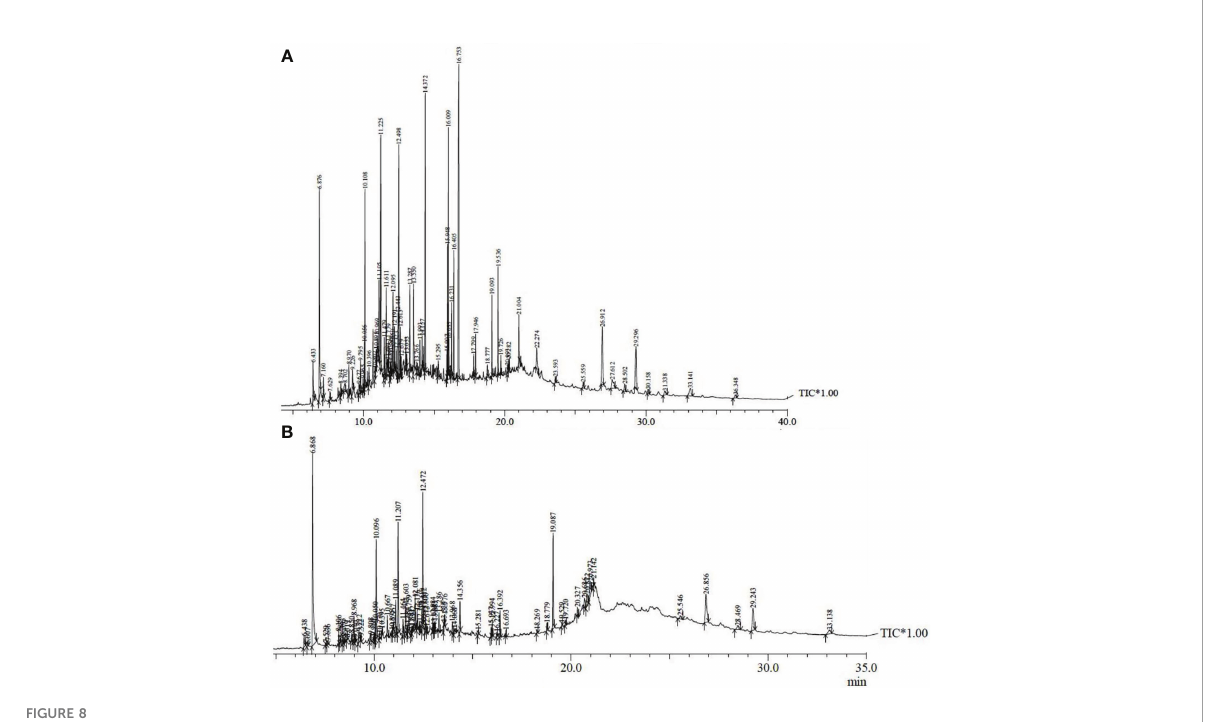
FIGURE 8 GC-MS chromatogram for different extracts (A) MCNJ (B)